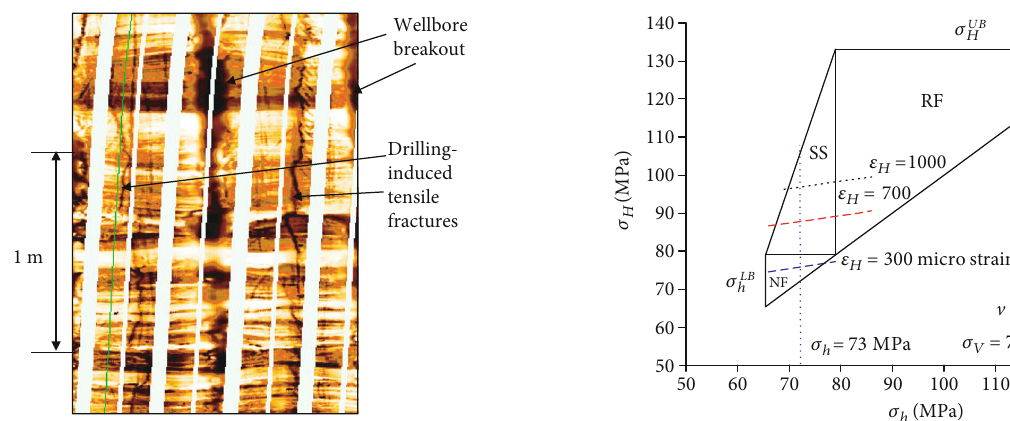
Figure 10: Stress polygon diagram for estimating the maximum horizontal stress using Eq. (31) for three maximum horizontal strains (dash